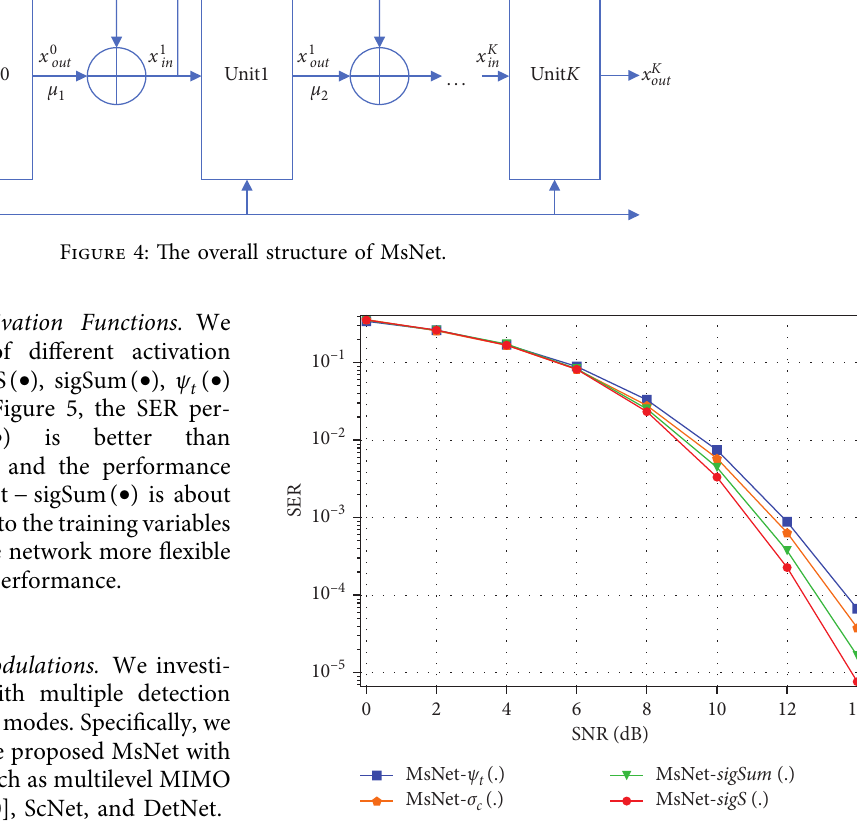
Figure 5: SER with different activation functions for MsNet: M � 32 and N � 64.